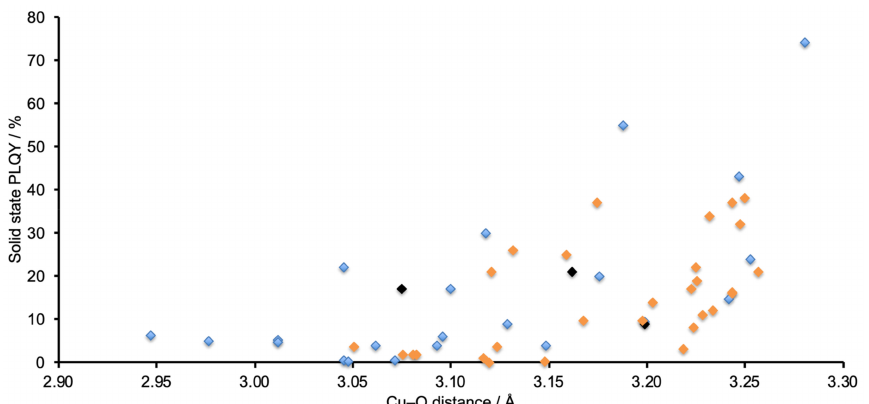
Figure 12. Solid-state PLQY values as a function of crystallographically determined Cu ··· O distances for [Cu(POP)(NˆN)] + (blue markers) and [Cu(xantphos)(NˆN)] + (orange markers) in which NˆN is bpy or a functionalized bpy, compared with data for [Cu(POP)( 2 )][PF 6 ], [Cu(xantphos)( 1 )][PF 6 ], and [Cu(xantphos)( 2 )][PF 6 ] (black